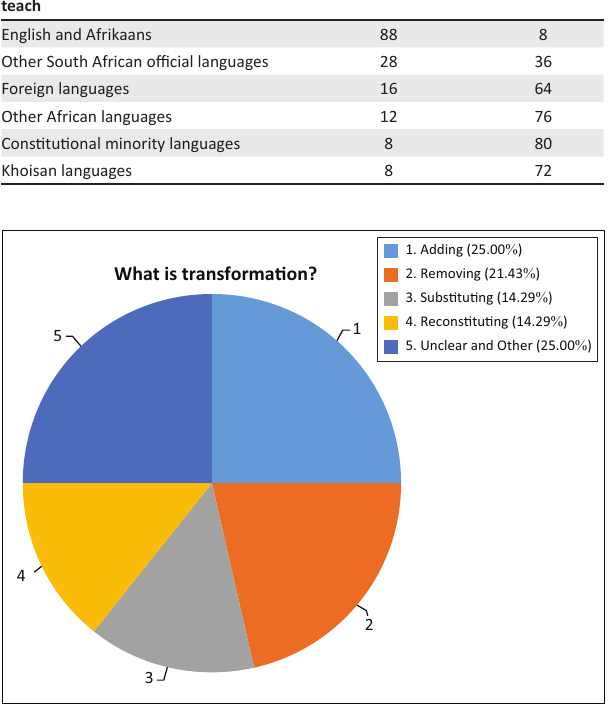
TABLE 5: Visibility of languages in the curriculum. Estimate the visibility of languages from the following groups in the courses you